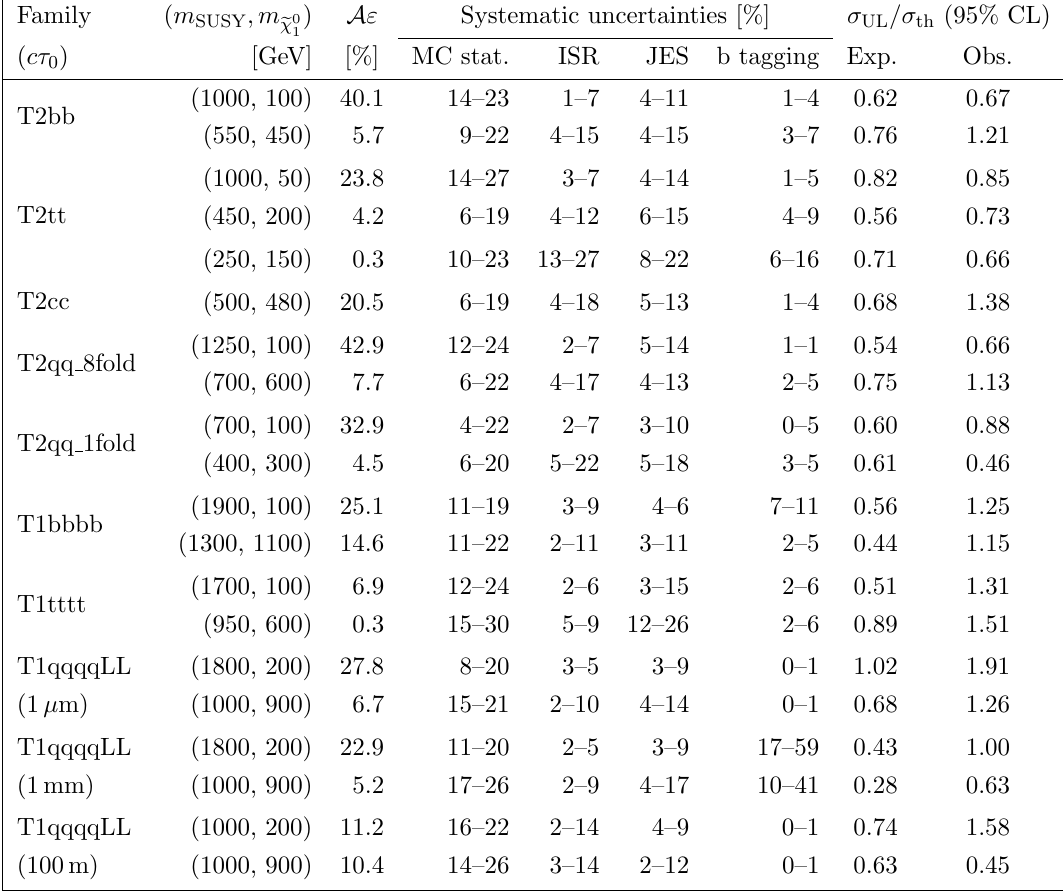
Table 4 . A list of benchmark simpli(cid:12)ed models organized according to production and decay modes (family), the A " , representative values for some of the dominant sources of systematic uncertainty, and the expected and observed upper limits on the production cross section (cid:27) UL relative to the theoretical value (cid:27) th calculated at NLO+NLL accuracy. Additional uncertainties concerning the T1qqqqLL models are not listed here and are discussed in the text.